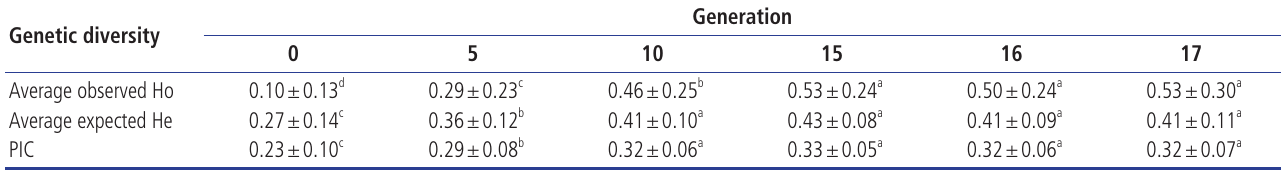
Table 2. Means and standard deviations for Ho, He, and PIC of MHC B-G genes in different generations Genetic